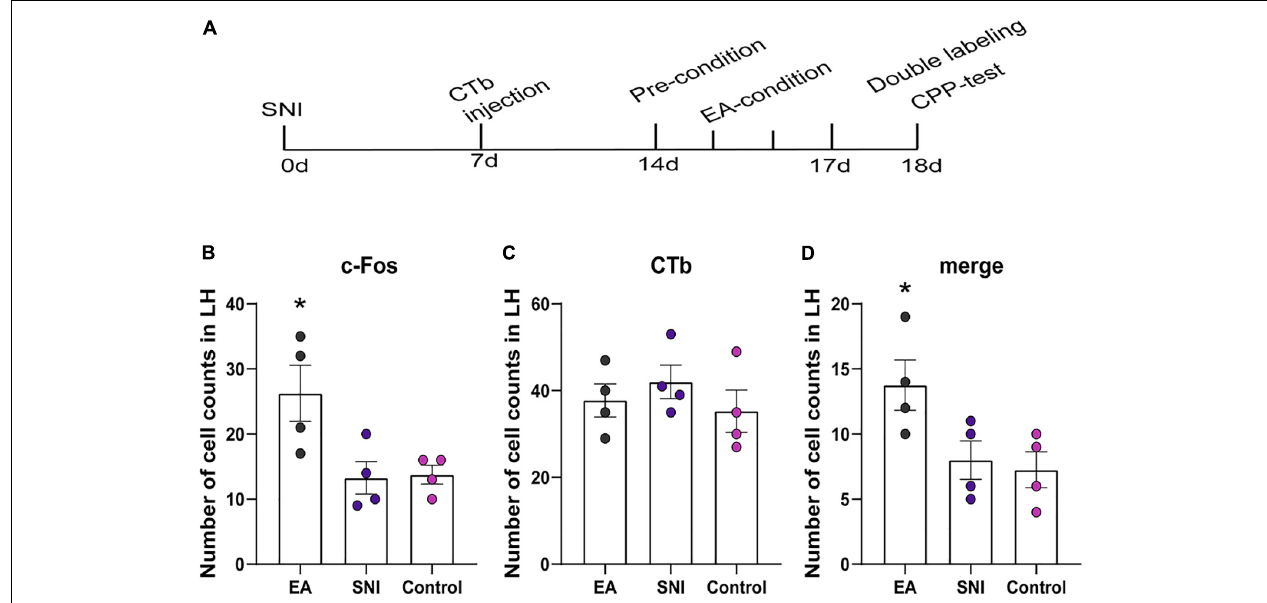
FIGURE 5 | The orexinergic neural pathway from the LH to the NAc shell was activated by EA-induced CPP. (A) A timeline of SNI modeling, CTb microinjection, EA induced CPP conditioning and testing. (B–D) The number of the c-Fos positive neurons, CTb stained neurons, and double-labeled CTb/Fos neurons in the NAc shell. * p < 0.01 vs. SNI group and control group.